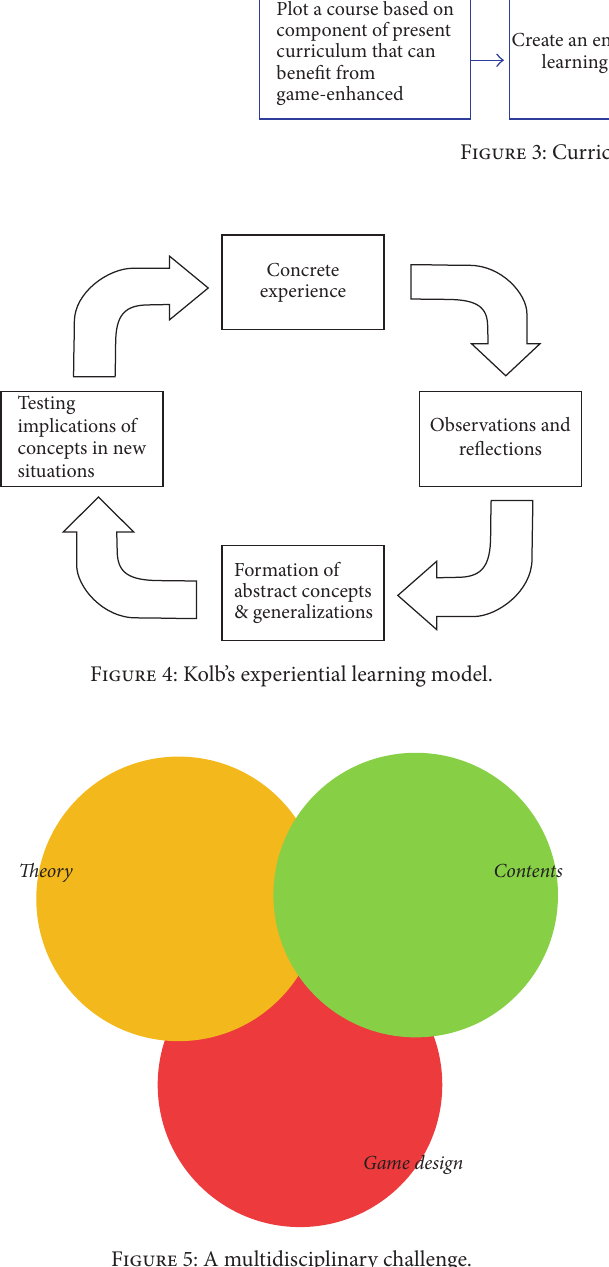
Figure 5: A multidisciplinary challenge.